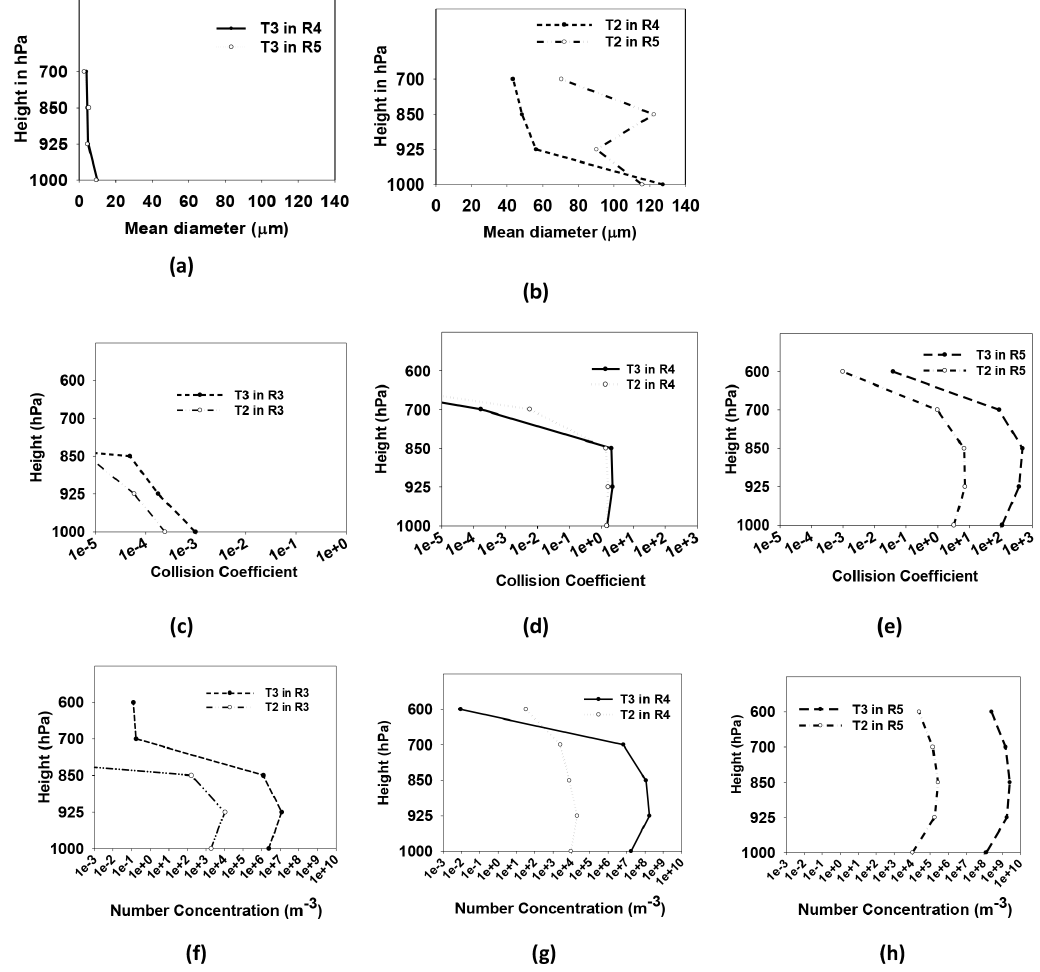
Figure 4. Panel (a) shows the vertical profile of mean diameters of cloud droplets for T3 in R4 and R5; (b) is the same as (a) but for T2. Panel (c) shows the collision coefficient for T2 and T3 in R3; (d) and (e) are the same as (c) but for R4 and R5. Panel (f) shows the cloud droplet number concentration for T2 and T3 in R3; (g) and (h) are the same as (f) but for R4 and R5.